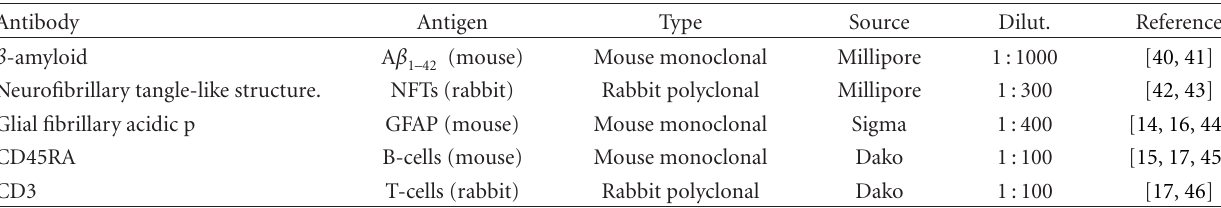
Table 1: Antibodies used for